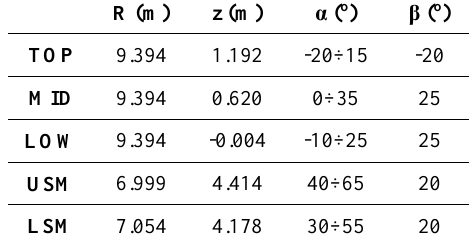
Table 1a. Beam starting position and injection angles.